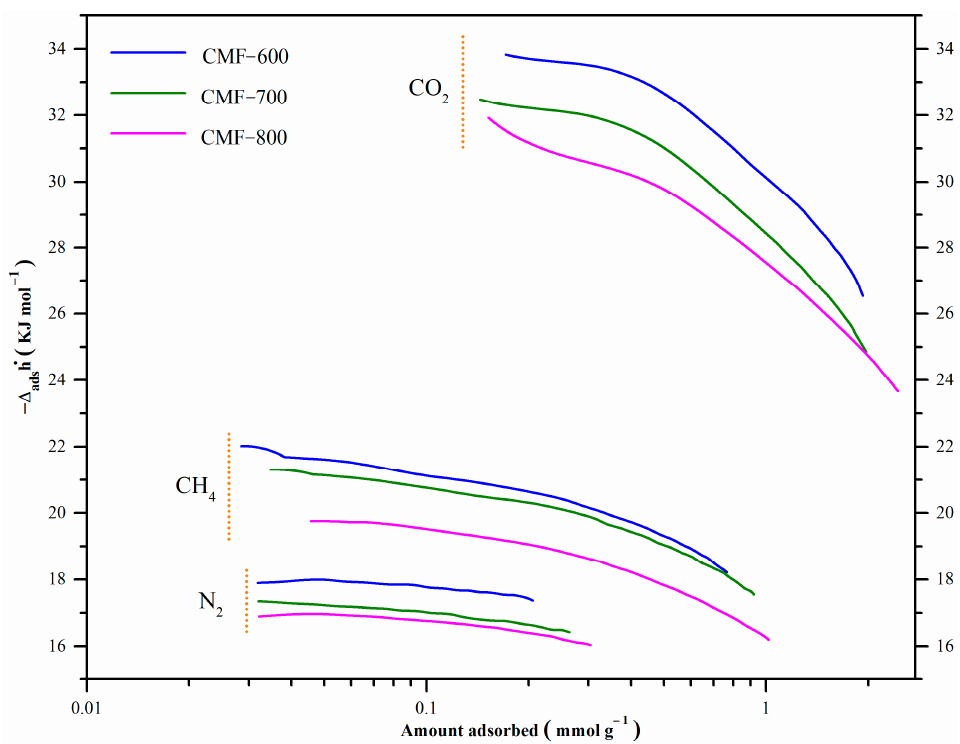
Figure 10. CO 2 , CH 4 , and N 2 isosteric enthalpy for carbon microfibers. Table 3. CO 2 , CH 4 , and N 2 adsorbed (mmol/g adsorbent) at 1.0 bar in PANMF carbonized.